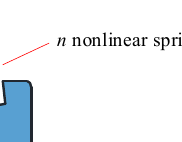
1750 Table 2. Load parameters of the shaft system. F x /N